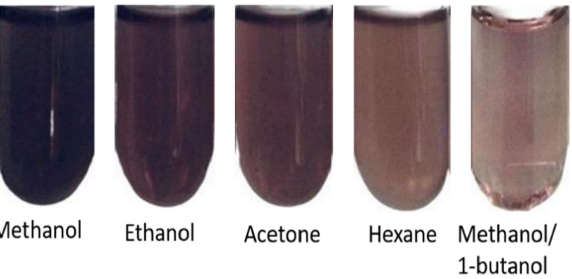
Figure 1. Degree of turbidity on the reaction of mixture solvent-lycopene and DPPH radicals. Once the methanol ‐ 1 ‐ butanol was identified as the best solvent with less turbidity, the determination of antioxidant inhibition was performed.